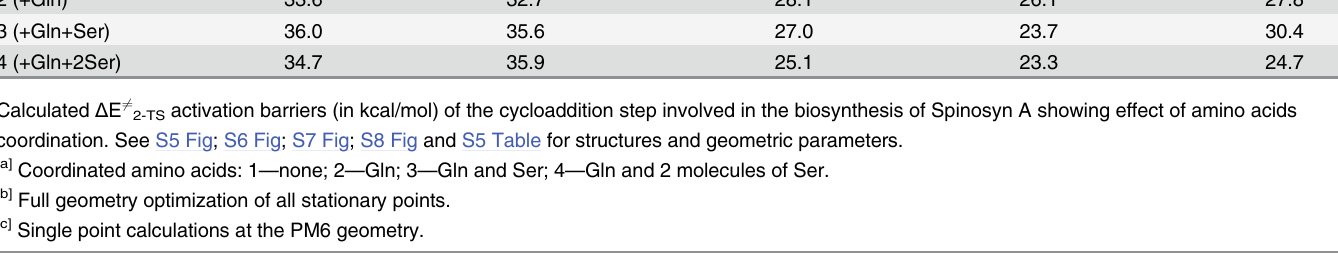
Influence of hydrogen bonding. The third important point is a possible influence of hy- drogen bonding on the reactivity of the substrate in the cycloaddition reaction. These interac- tions may facilitate cycloaddition in the active site of enzymes due to modulation of energies of the HOMO/LUMO molecular orbitals by specific hydrogen bonding. Positioning of a hydro- alkene (decreasing the energy of LUMO) could narrow the energy gap and lower the activation